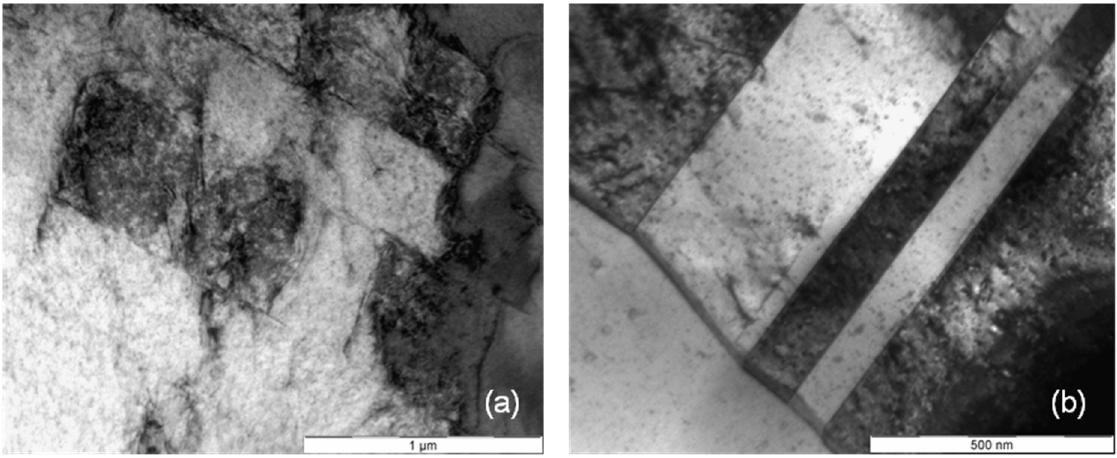
Figure 9. ( a ) Deformation structure and ( b ) deformation bands in an F-562 stent bow (Medtronic